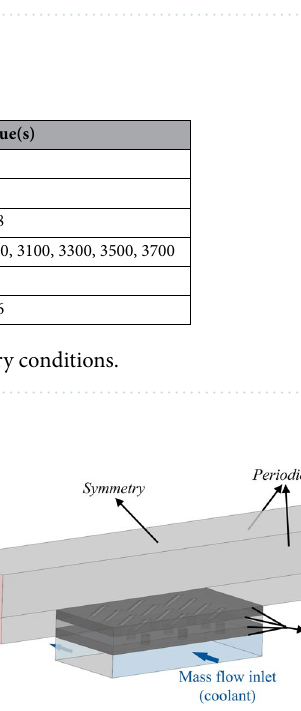
Table 5. Specific parameters for each case.